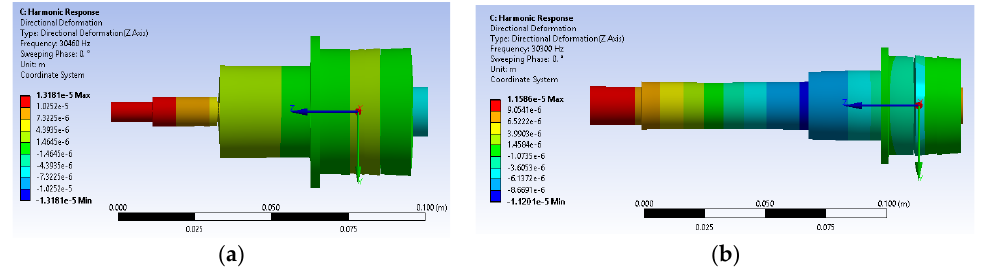
Figure 6. Mode shapes from FE modal analysis for T2; ( a ) Mode 1; ( b ) Mode 2; ( c ) Mode 3; and ( d ) Mode 4.